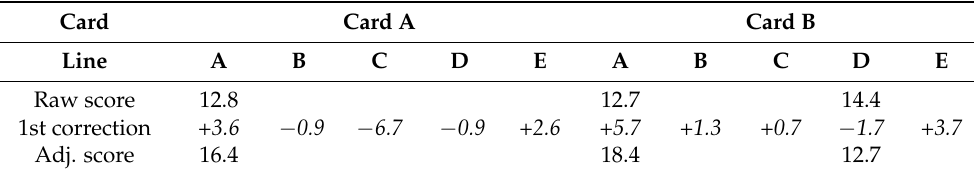
Table 15. Example 2 of application of GVT in one case: raw